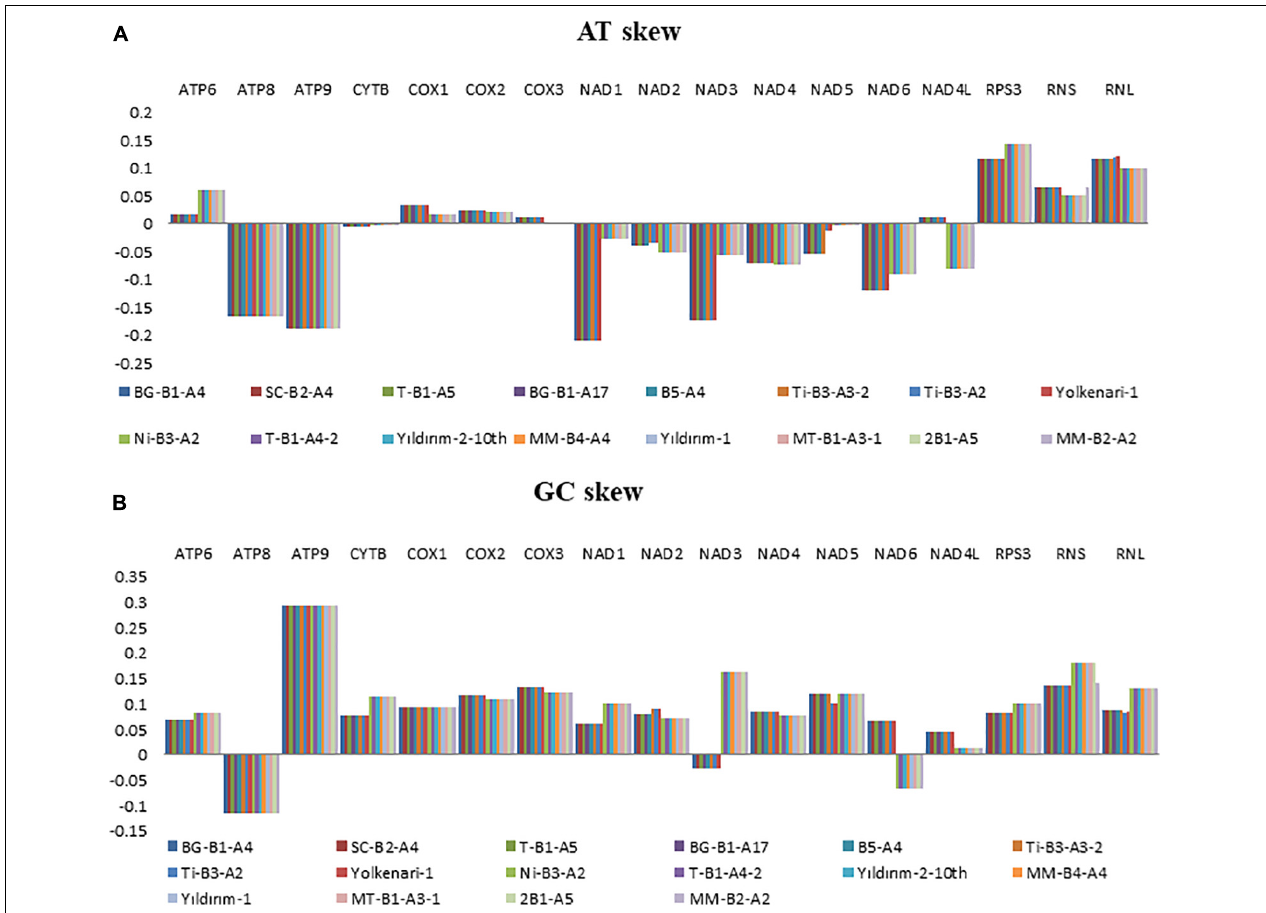
FIGURE 2 | Graphical illustration showing the (A) AT- and (B) GC-skew in the mitochondrial genes of the 16 isolates of Monilinia spp.